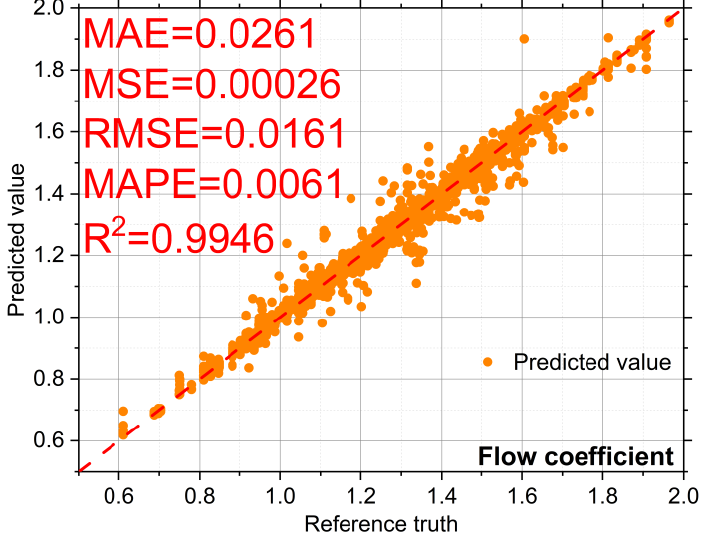
Figure 16. Accuracy of emitter flow coefficient prediction model based on the extended dataset.